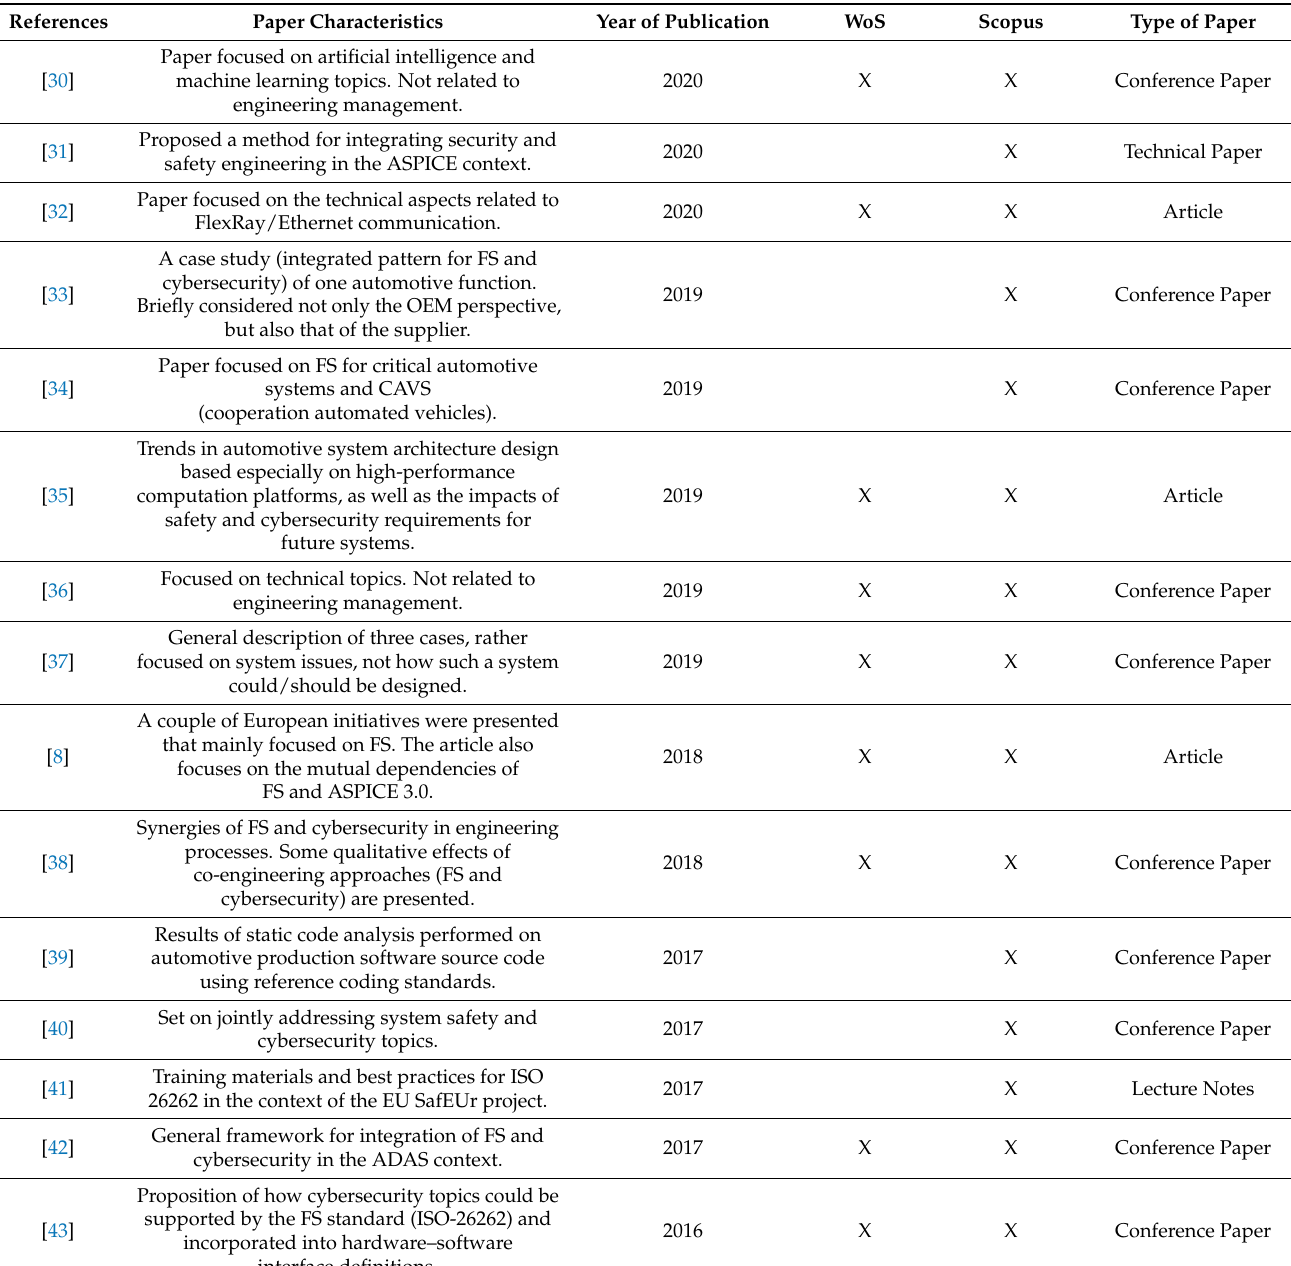
Table 2. Summary of the literature review in WoS and Scopus